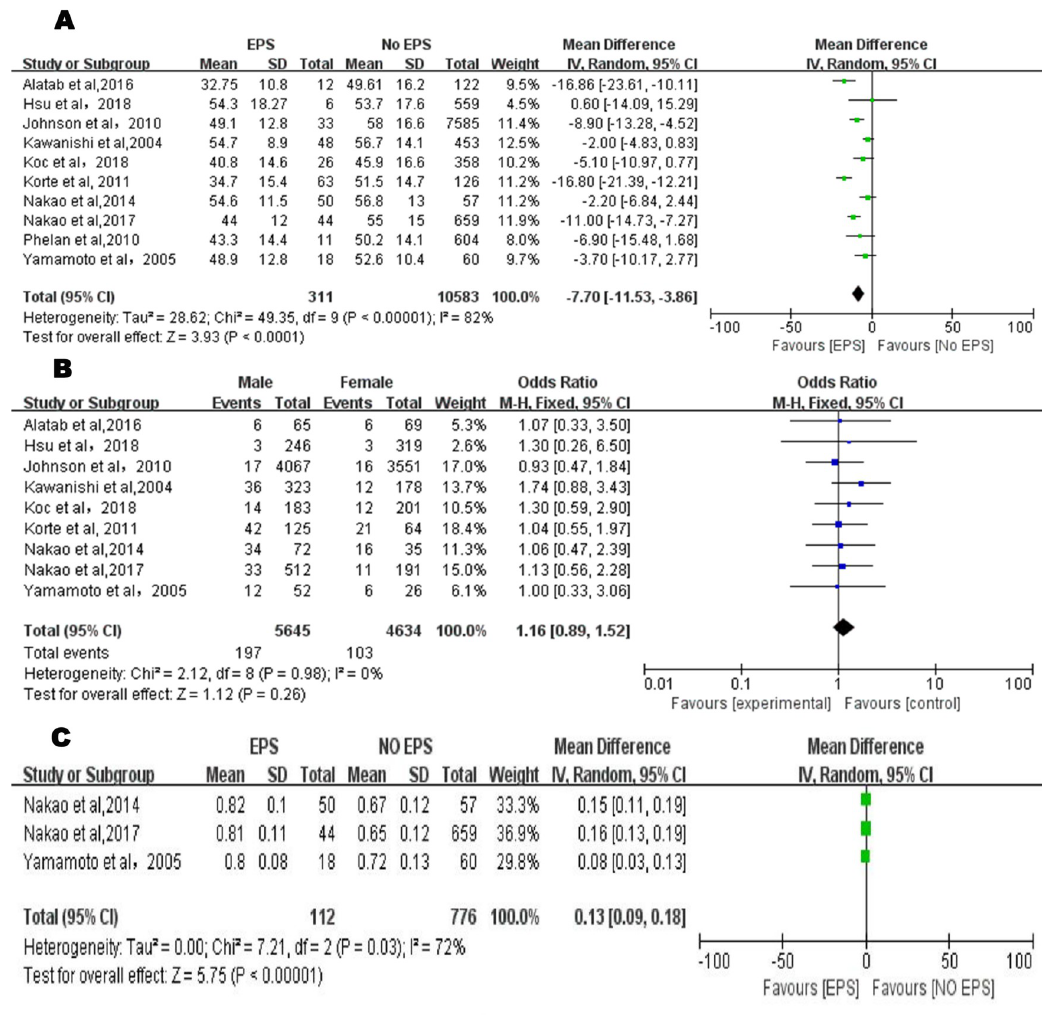
Fig 2. A. Forest plot of age at PD onset and EPS in the exploratory meta-analysis. The mean difference and 95% CI for each study and the final combined results are displayed numerically on the left and graphically as a forest plot on the right. B. Forest plot of sex and EPS in the exploratory meta-analysis. The odds ratio and 95% CI for each study and the final combined results are displayed numerically on the left and graphically as a forest plot on the right. C. Forest plot of D/P Cr and EPS in the exploratory meta-analysis. The mean difference and 95% CI for each study and the final combined results are displayed numerically on the left and graphically as a forest plot on the